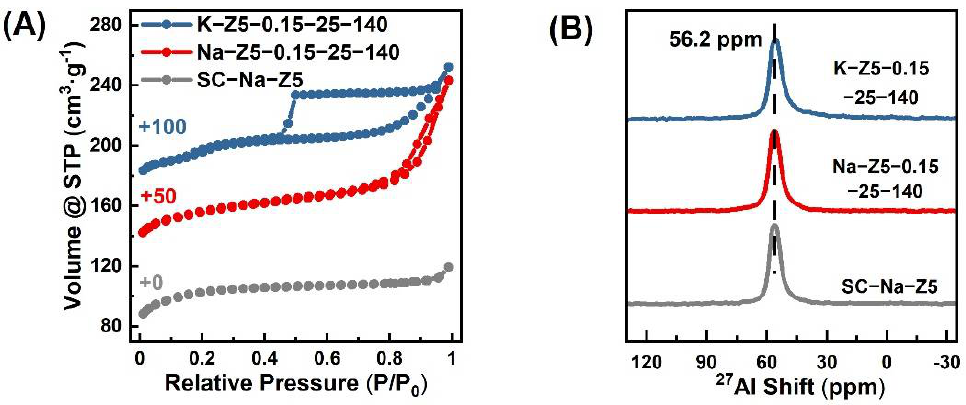
Figure 4. ( A ) N 2 sorption isotherms at 77 K and ( B ) 27 Al MAS NMR spectra over three typical ZSM-5 zeolite samples.